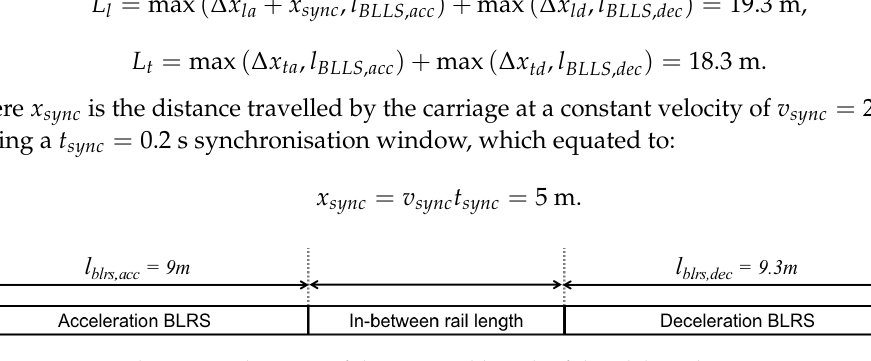
Figure 12. An explanatory schematic of the required length of the